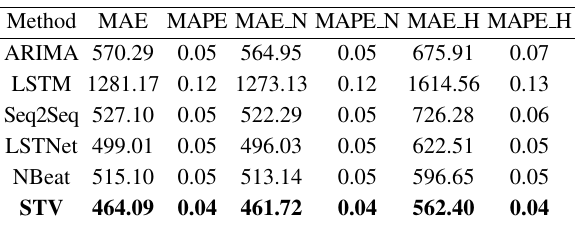
Table 4 Model comparison on the ElecCONS